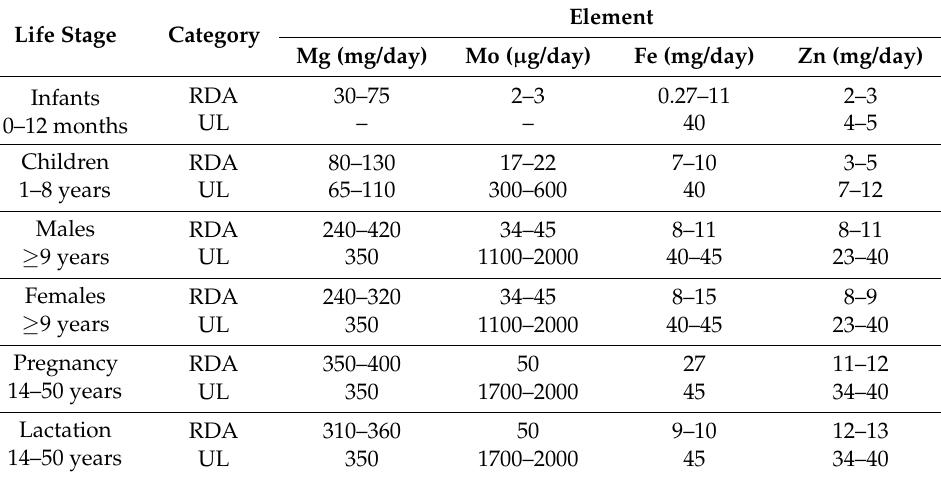
Table 1. The recommended dietary allowance (RDA) and tolerable upper intake levels (UL) of biodegradable elements